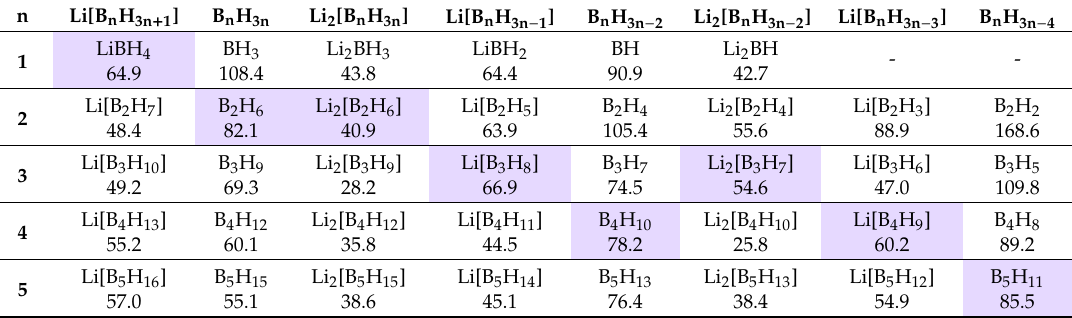
Table 1. Calculated hydride donating ability in MeCN (HDA MeCN in kcal / mol) for homologous series of neutral and anionic boranes